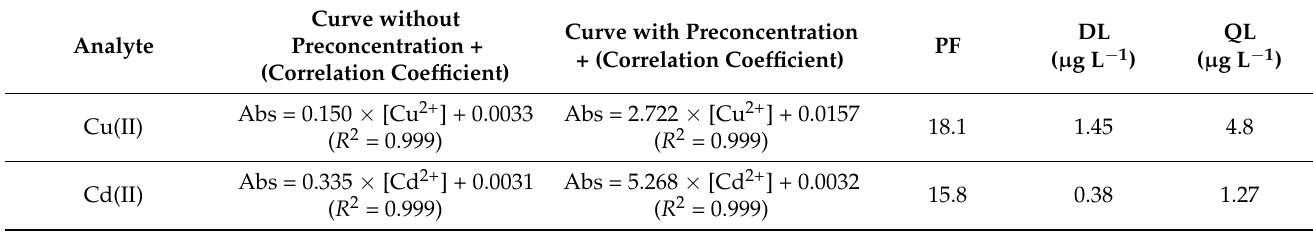
Table 8. Analytical performance of the proposed preconcentration